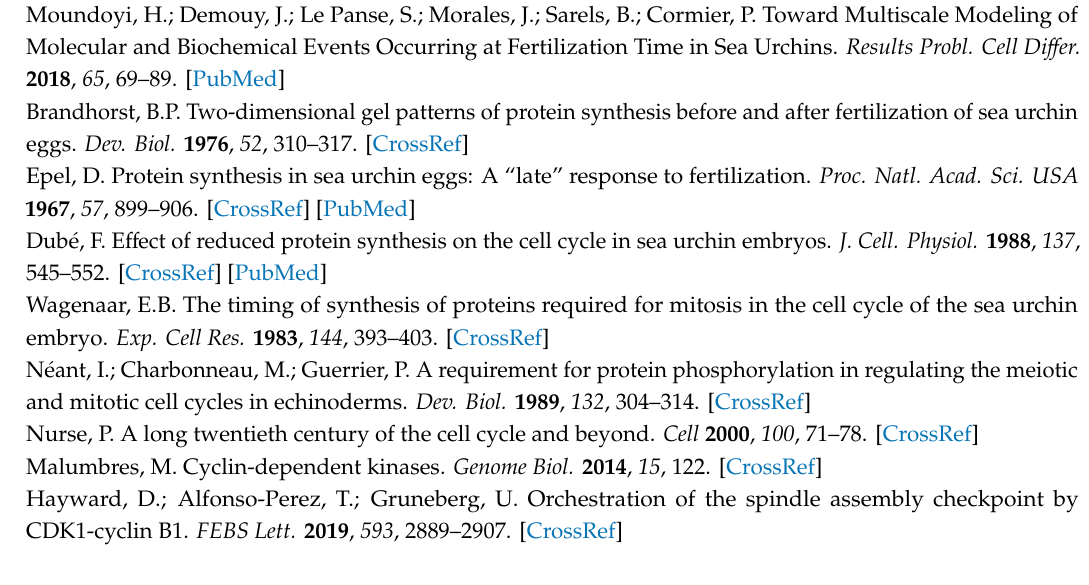
Figure S1: The JY325 antibody recognises specifically the T3H3ph form in sea urchin protein extracts. Figure S2: A peak of T3H3 phosphorylation precedes cell cleavage in S. granularis early embryos. Figure S3: The T3H3ph signal is uniformly distributed over the chromatin during prometaphase and